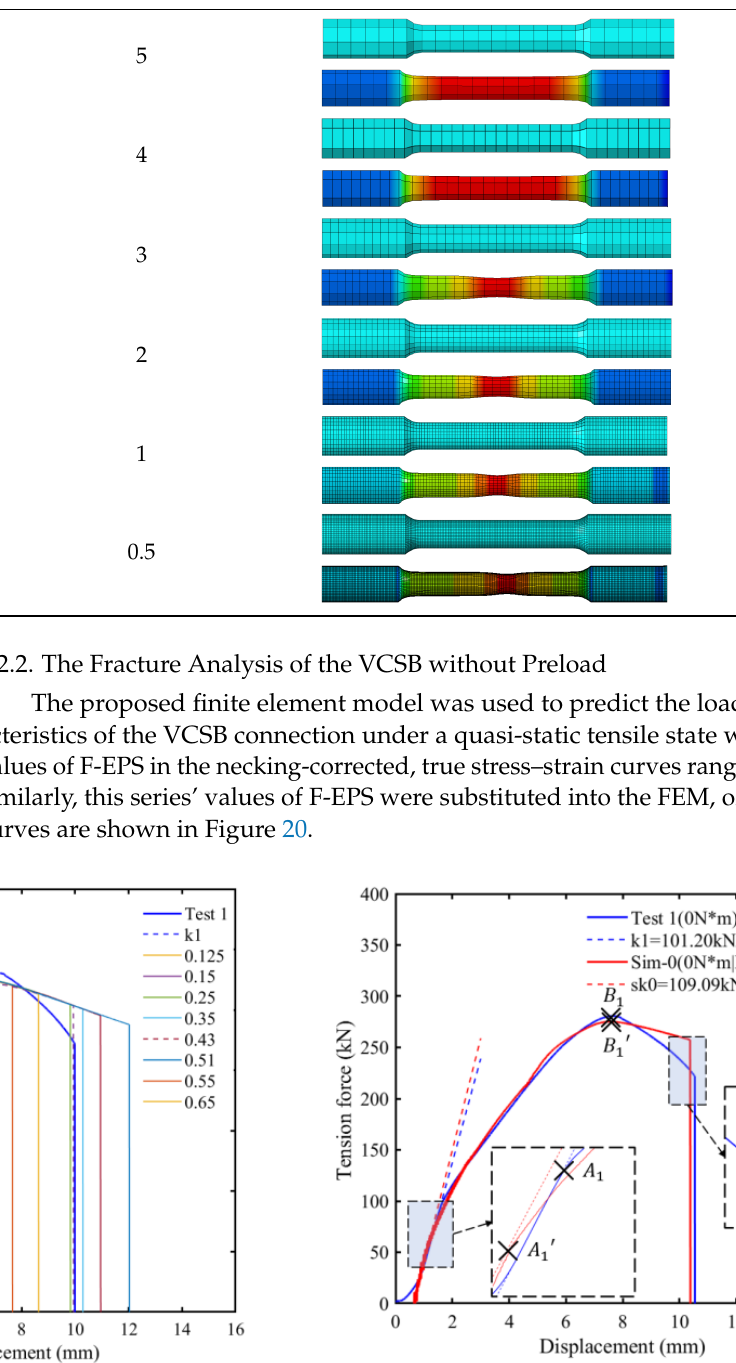
Figure 20. Comparison of test and FEM loading curves in the tension without preload: ( a ) The FEM loading curve with F-EPS value of 0.125-0.65 and Test 1, ( b ) Loading curves of the Test 1 and Sim-0(FEPS=0.43).